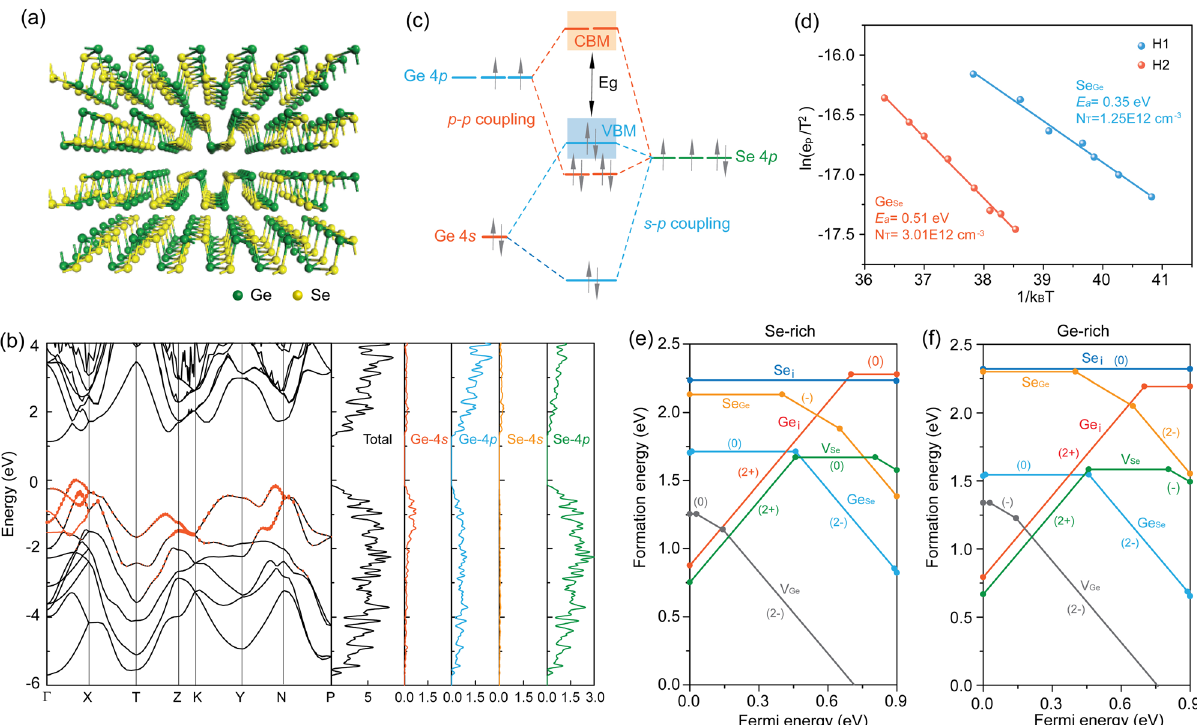
Fig. 1 Point defect properties of GeSe. a Crystal structure of GeSe. b Calculated bandstructure, density of states (DOS), and partial DOS projected on different elements of GeSe. c Schematic energy level diagram of the interactions in GeSe. d Arrhenius plots obtained from DLTS experiments. The solid lines represent the best fi ts to experimental data. Calculated formation energies of intrinsic point defects in GeSe under e Se-rich and f Ge-rich conditions as a function of the Fermi